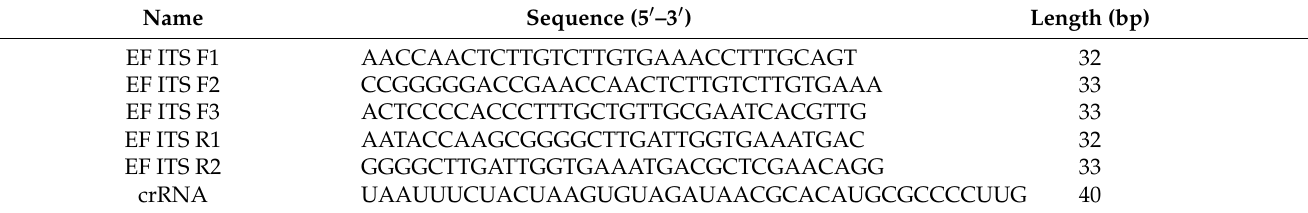
Table 1. The primers used in the RPA reaction and the CRISPR guide RNA (crRNA) in the Cas12 reaction.